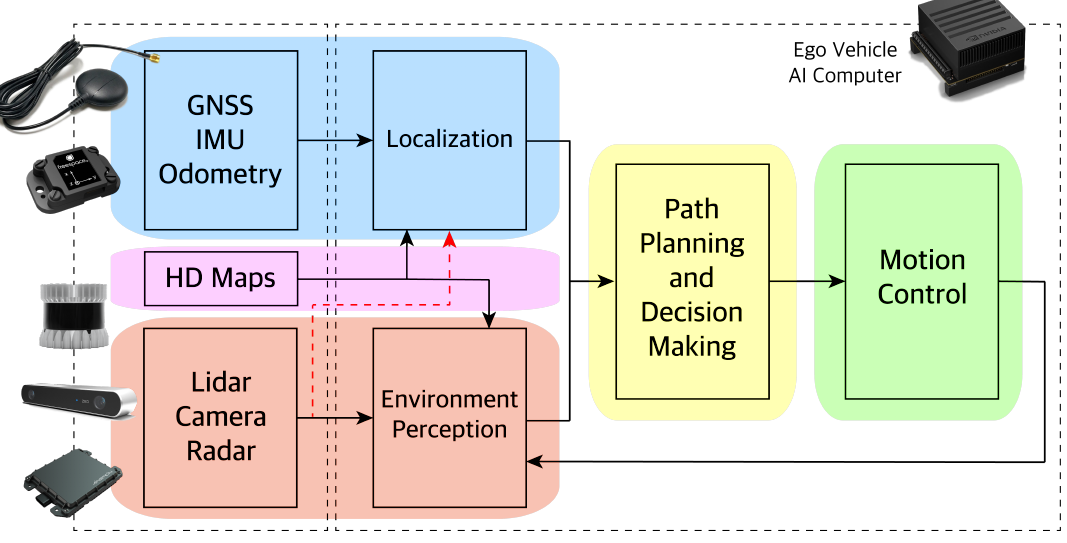
Figure 1. Autonomous vehicle architecture. Our paper focuses on the perception (red